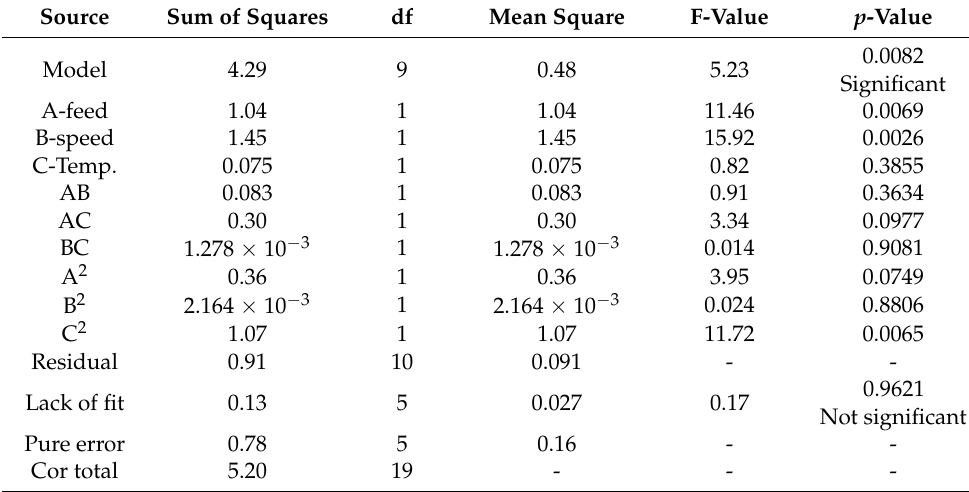
Table 4. Analysis of variance table for R a.